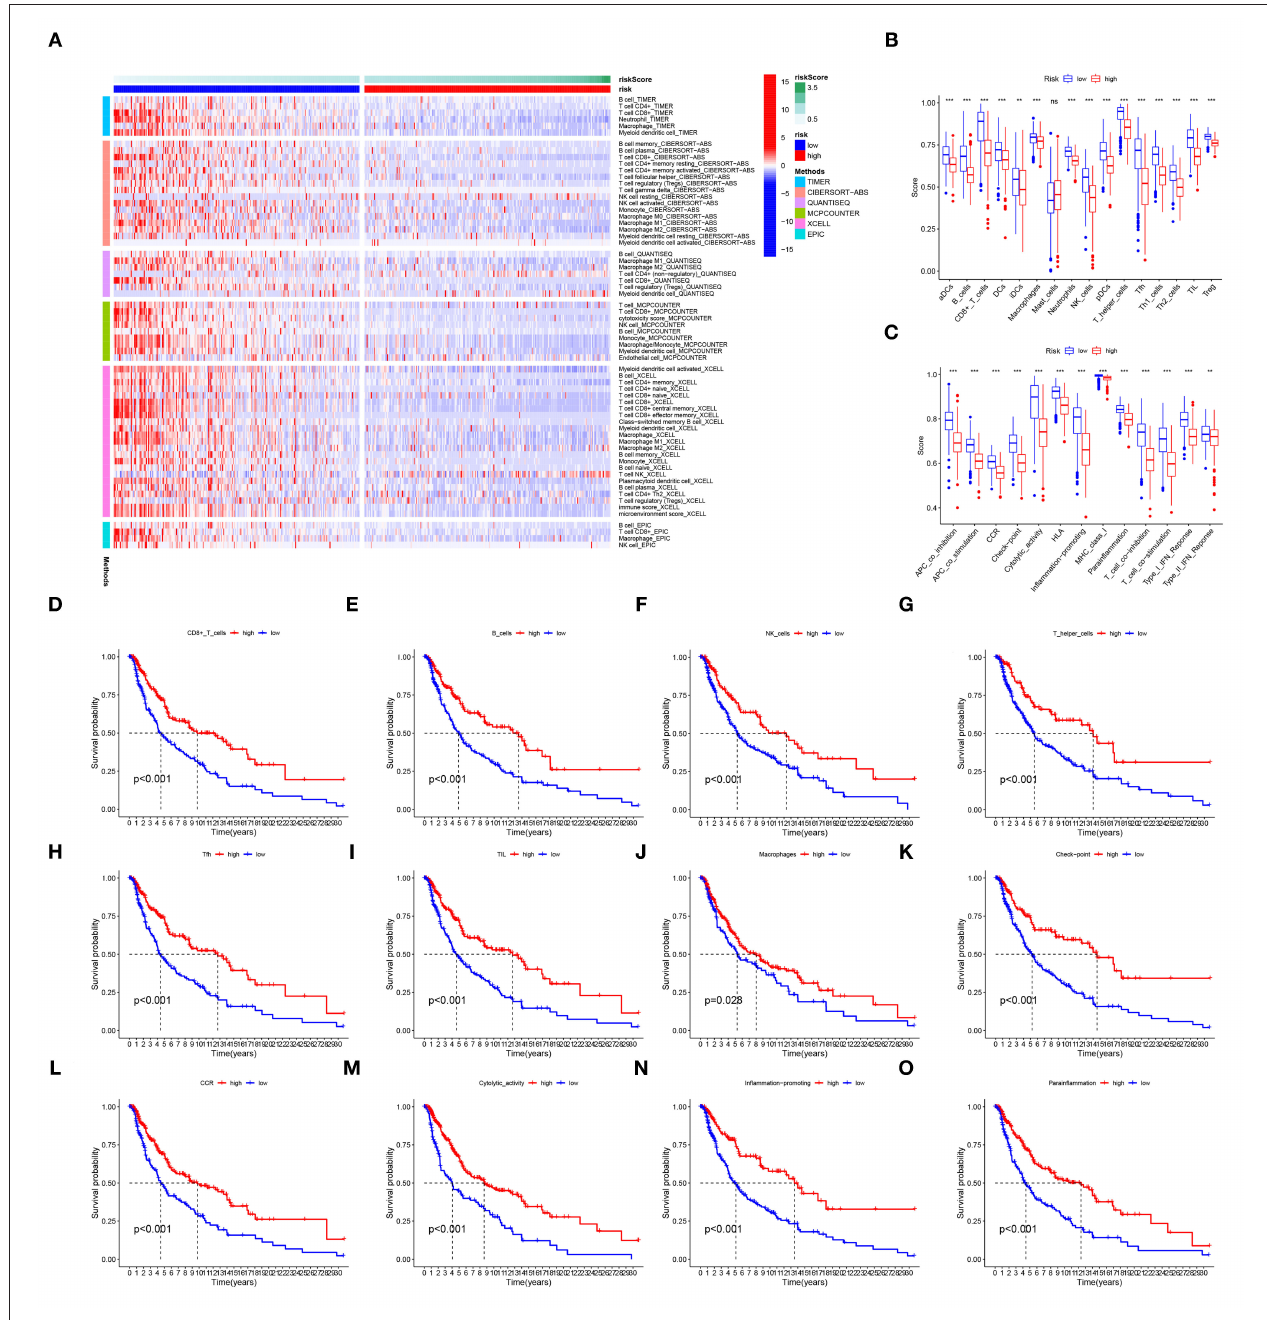
FIGURE 7 | TME. (A) Immunocyte infiltration according to analyses with the CIBERSORT, ESTIMATE, MCPcounter, EPIC, XCELL, and TIMER algorithms. (B,C) The immune cells and functions identified with ssGSEAs. (D–O) The survival of patients is grouped by levels of immune checkpoints, CD8 + T cells, inflammation, TILs, and T helper cells. ns, not significant; ** p < 0.01; *** p <